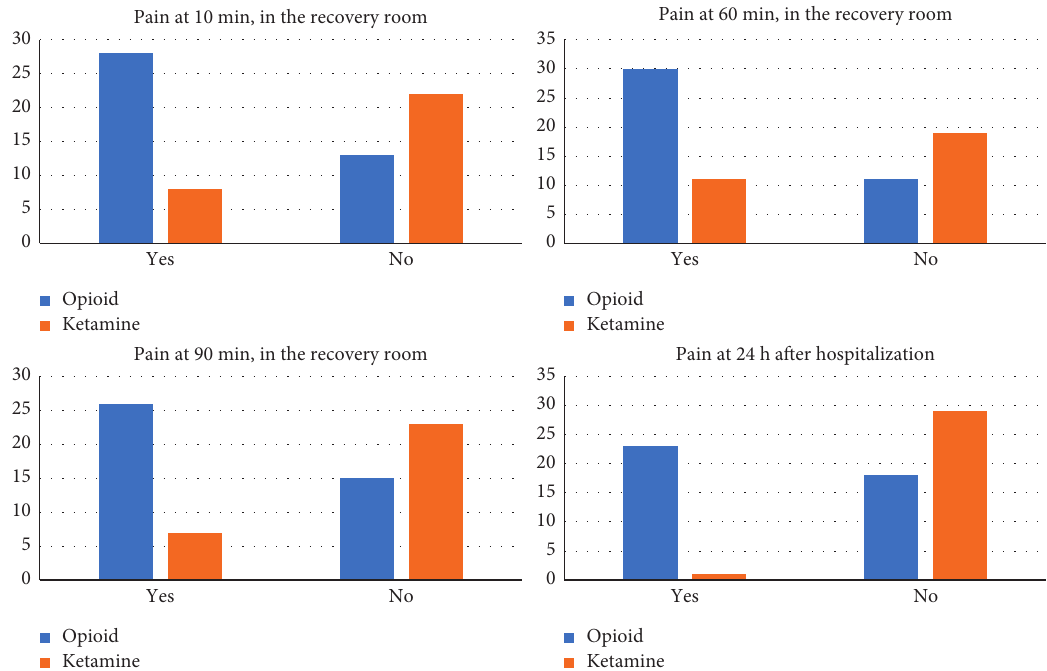
Figure 3: Number of patients of pain at different times (blue with opioid and green with ketamine). Table 2: APP and its intensity using the numerical rating scale (NRS) measured at different times in addition to the need for rescue analgesia during recovery and